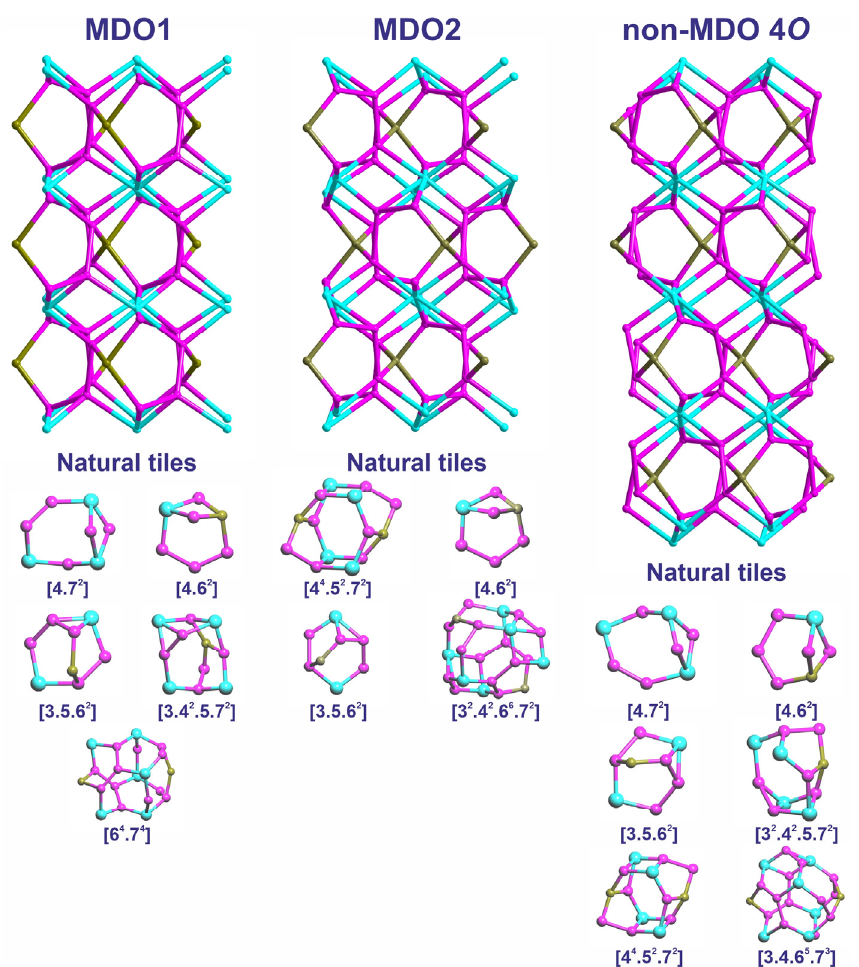
Figure 5. Topological features of the 3D cationic nets of the heteropolyhedral MT -frameworks in the structures of MDO1, MDO2 and non-MDO 4O polytypes of compounds with the general formula